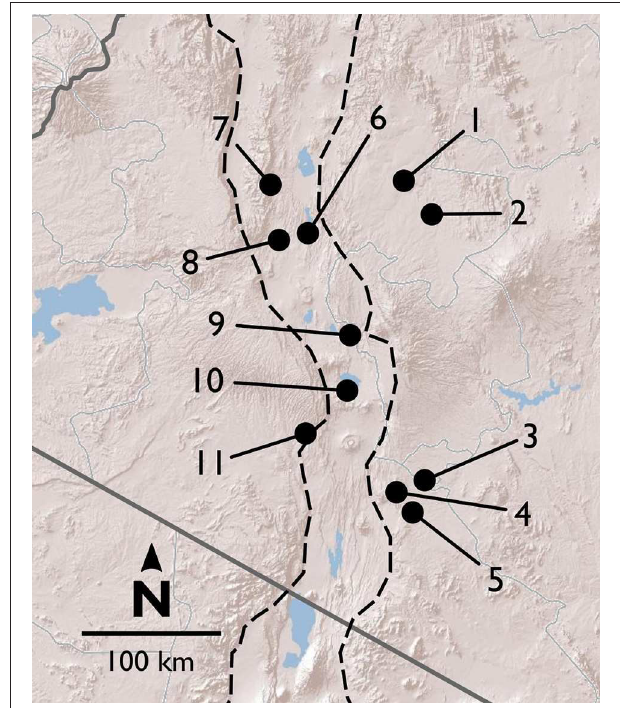
FIGURE 1 | Map of field sites in and around the Rift Valley in central and southern Kenya (Rift shown by dashed lines). Terrain image: Esri (2009). Northern highlands east of the Rift: 1. Suyian